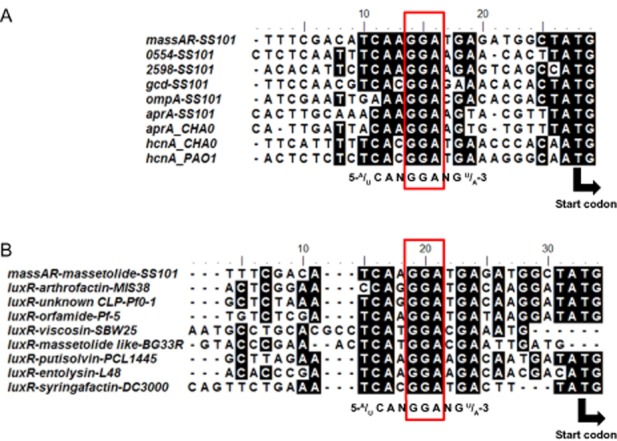
A. Alignment of the upstream regions of five putative target genes of the RsmA and RsmE repressor proteins of P. fluorescens SS101. The aprA and hcnA genes of P. protegens CHA0 and P. aeruginosa PAO1 were used as references. The translation initiation ATG codon is shown at the 3′ end. B. Alignment of the regions upstream of LuxR-type transcriptional regulatory genes that flank different lipopeptide biosynthesis gene clusters in Pseudomonas fluorescens SS101, Pseudomonas sp. MIS38, P. fluorescens Pf0-1, P. protegens Pf-5, P. fluorescens SBW25, P. synxantha BG33R, P. putida PCL1445, P. entomophila L48 and Pseudomonas syringae pv. tomato DC3000. The translation initiation ATG codon is shown at the 3′ end.